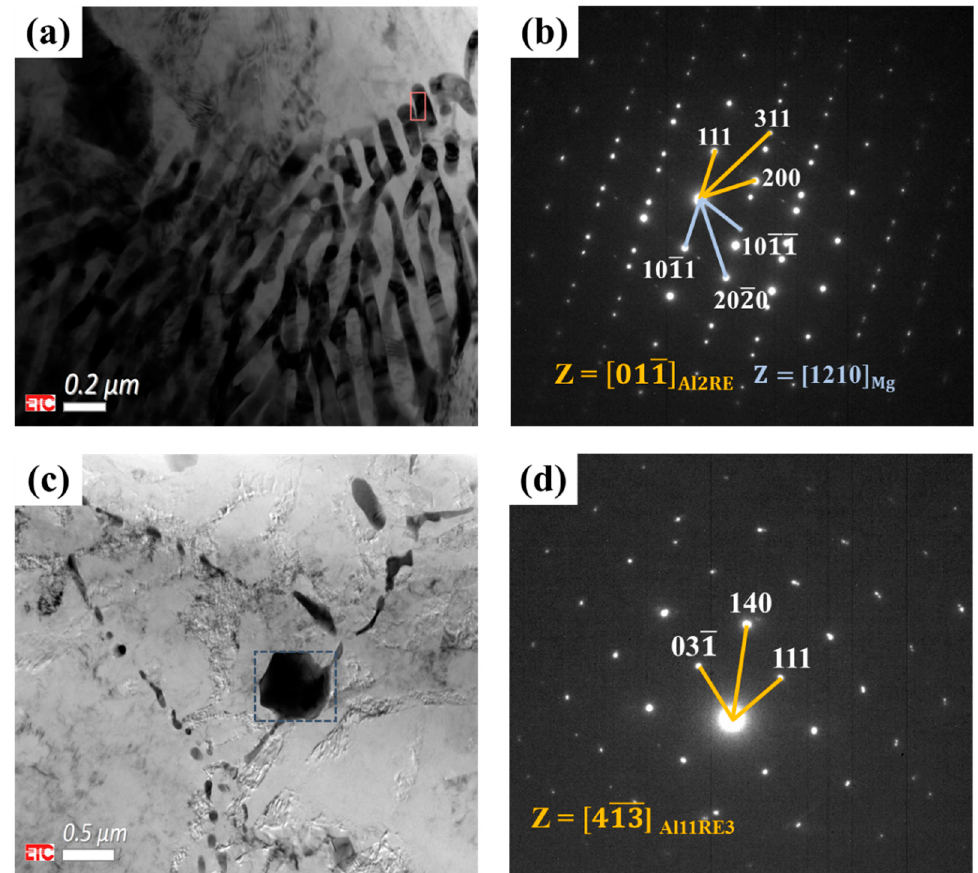
Figure 7. ( a , c ) BF-TEM image, ( b , d ) the corresponding SAED pattern with the analysis results of